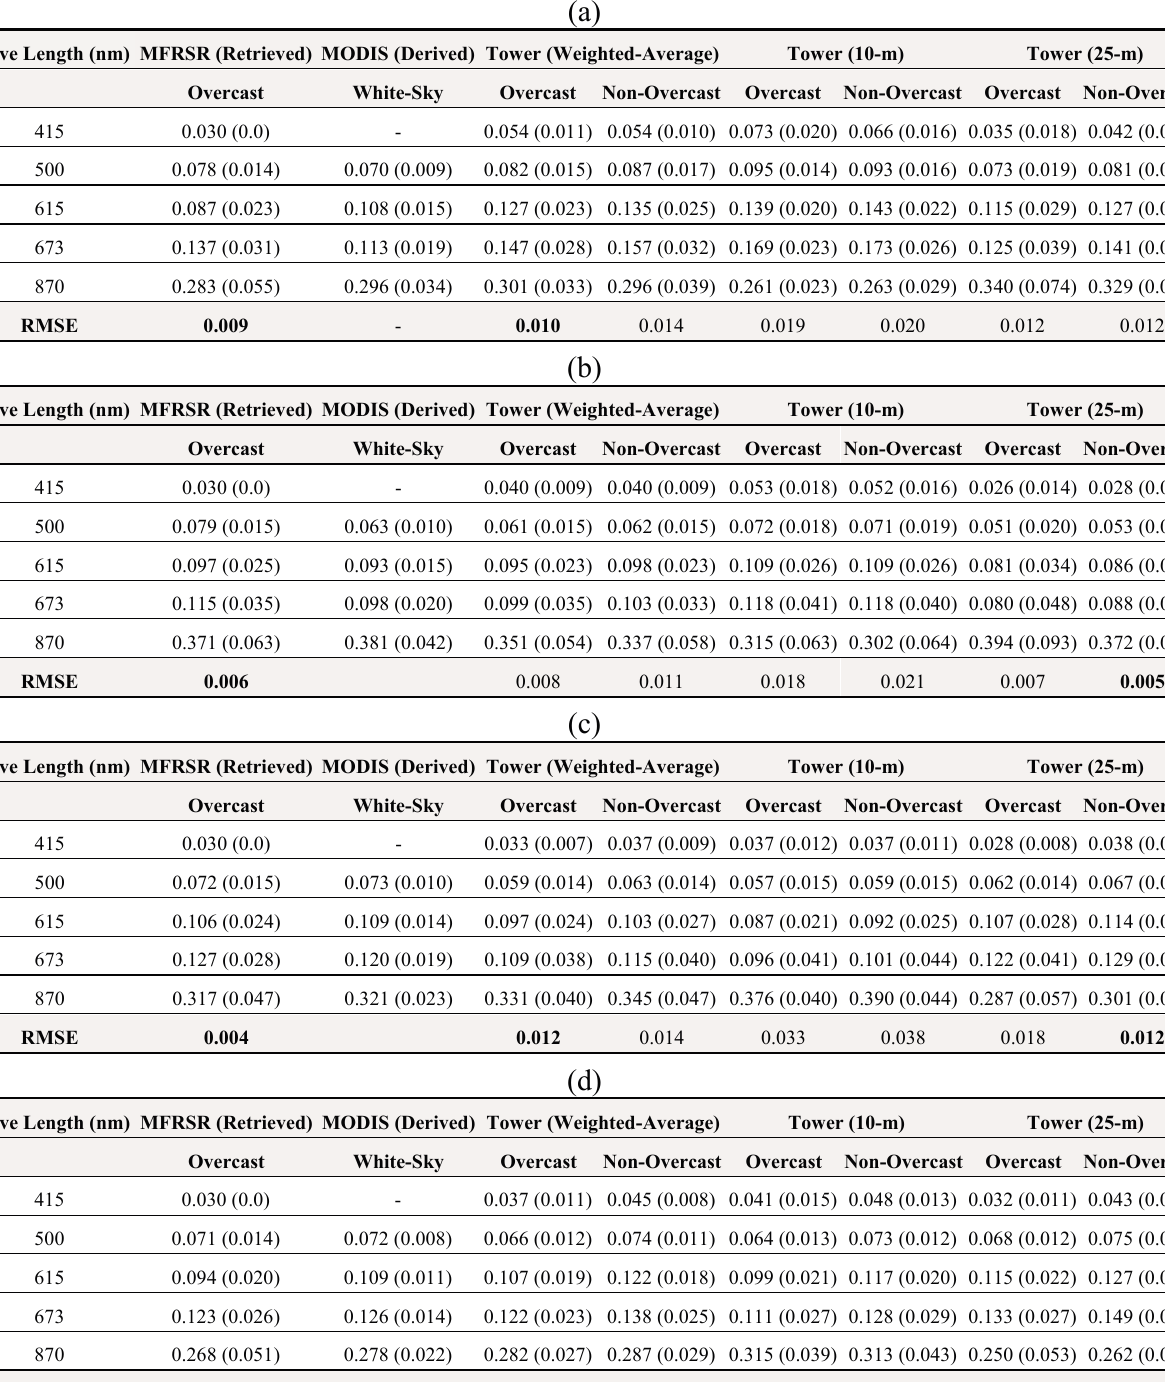
Table 2. Time-averaged albedos and the corresponding standard deviations (in parenthesis) derived from the indicated platforms for the ARM site, segregated by season: winter ( a ), spring ( b ), summer ( c ), fall ( d ). For the tower data, both fully overcast and non-overcast conditions are shown. The MODIS data have been interpolated/extrapolated to the nominal MFRSR wavelengths. The root mean square error (RMSE) is also shown (bottom row) using the MODIS albedos as the reference. The two lowest RMSE are indicated in bold. (a) Wave Length (nm) MFRSR (Retrieved) MODIS (Derived) Tower (Weighted-Average)